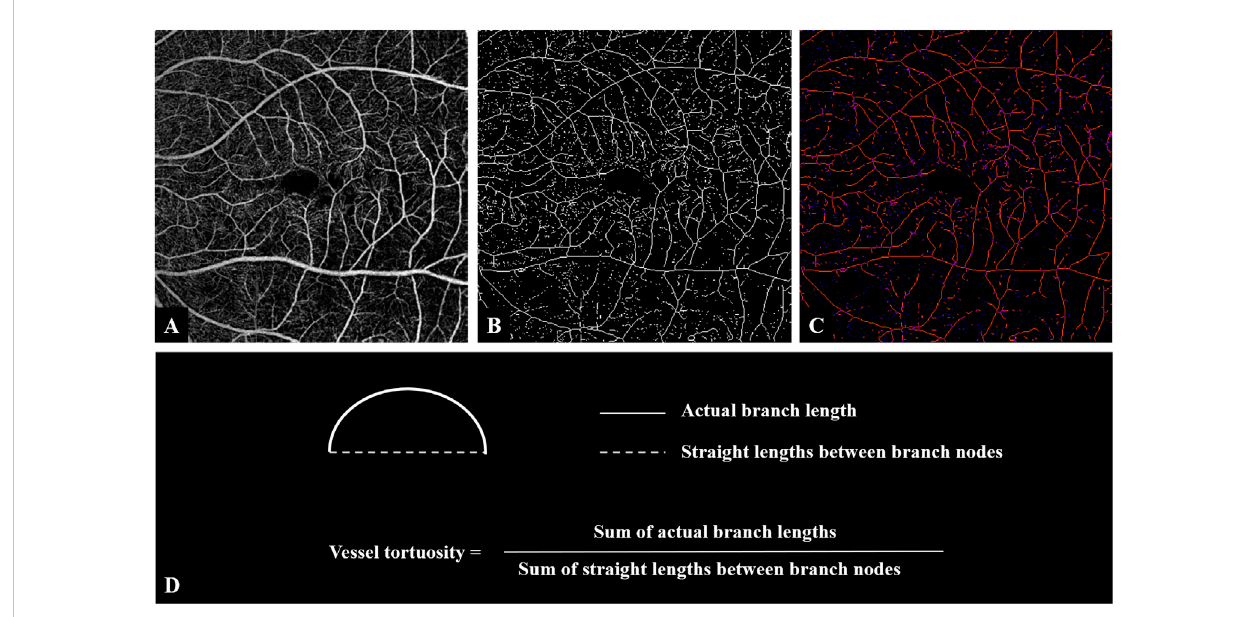
FIGURE 1 Image processing steps for analyzing vessel tortuosity. (A) OCTA image of the super fi cial retinal layer of an eye with iERM. (B) Binarized vessel was skeletonized. (C) The vessel branches and the branch nodes were obtained and the lengths of both actual branches and the imaginary straight lines between nodes were generated. (D) Vessel tortuosity was calculated as the sum of the branch lengths divided by the sum of the lengths of the imaginary straight lines. Abbreviations: iERM, idiopathic epiretinal membrane; OCTA, optical coherence tomography